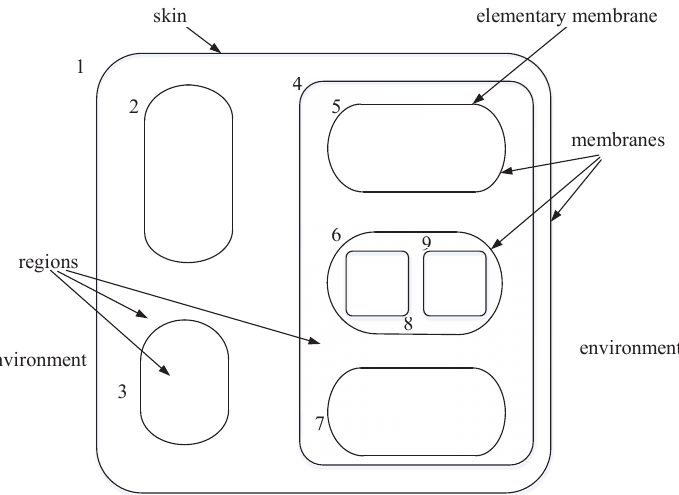
Figure 1. A cell-like P system